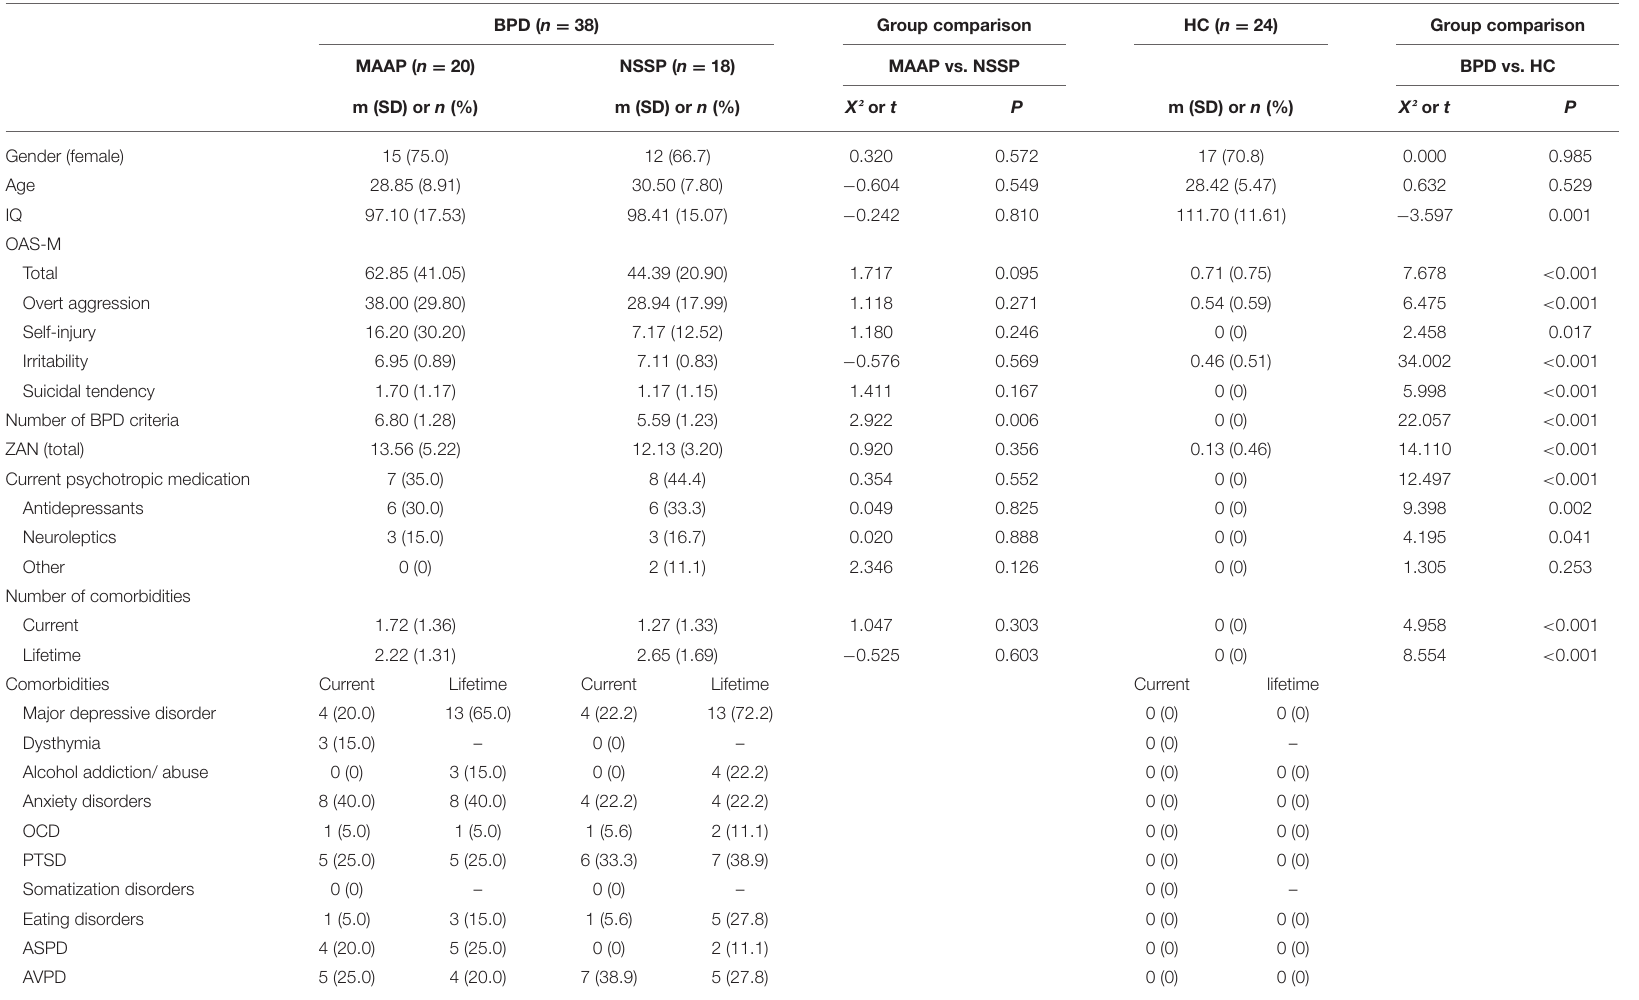
TABLE 1 | Demographic and psychometric information of patients with borderline personality disorder (BPD, randomized into MAAP or NSSP treatment) and healthy controls